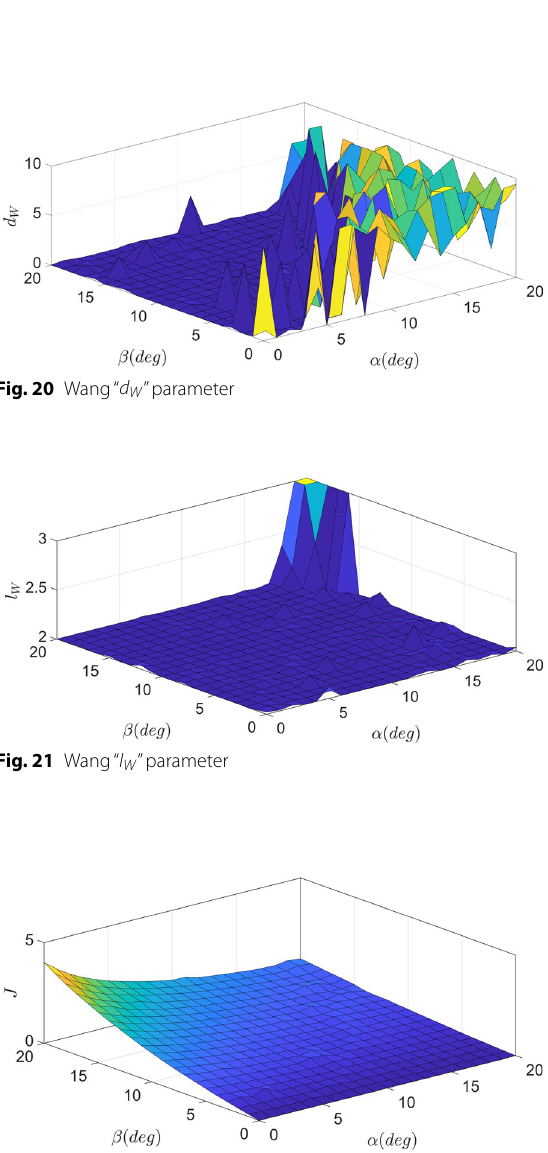
Fig. 22 Cost function values of wang shape